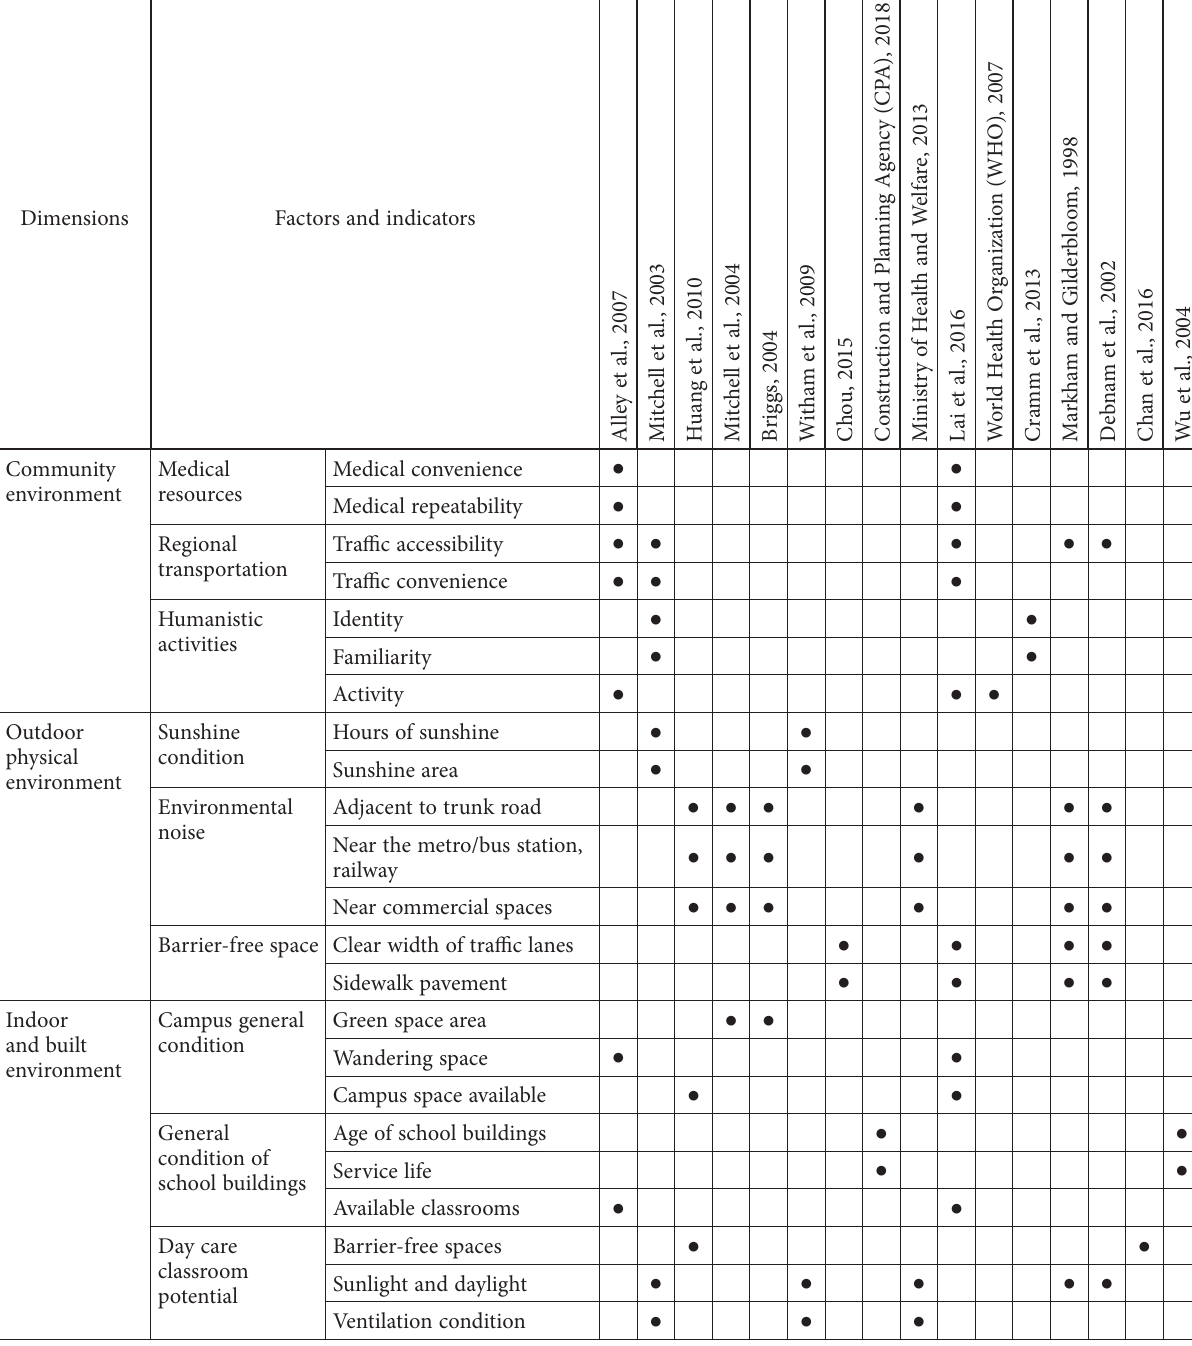
Table 1. Indicators literature